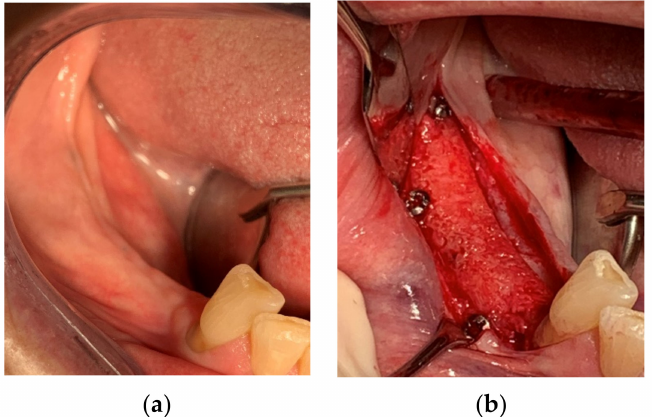
Figure 14. Clinical view before implant placement ( a ) and a full-thickness flap showing fixation ( b ).